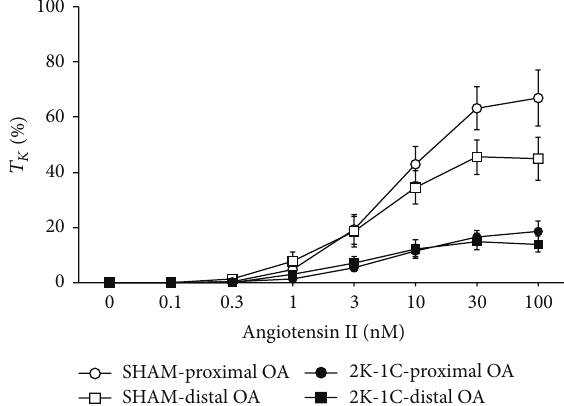
Figure 1: Dose-response effects of angiotensin II on tension of proximal and distal occipital artery segments from sham-operated (SHAM) and 2-kidney, 1-clip (2K-1C) hypertensive rats. The data are presented as mean ± SEM of the responses expressed as a percentage of that elicited by 80 mM K + (% 𝑇 𝐾 ). There were 8 segments in each